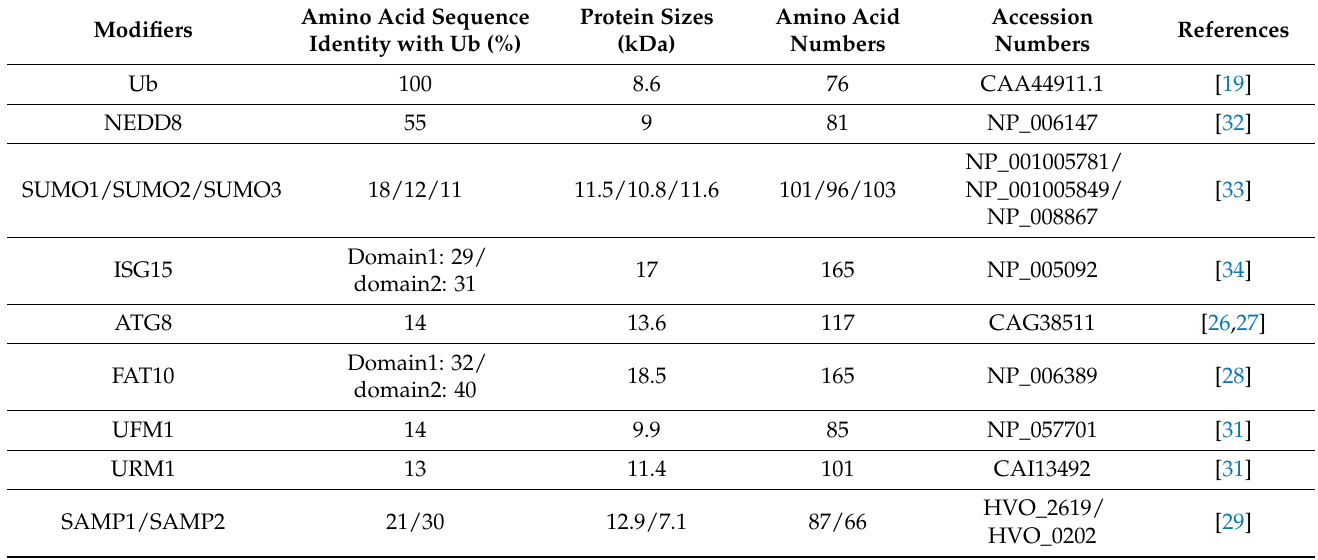
Table 2. Protein sequence alignment of Ub and